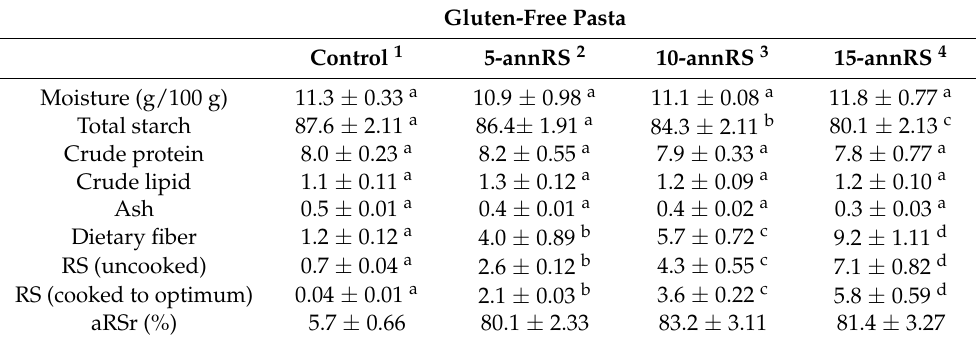
Table 1. Chemical composition (g/100 g dry matter) and apparent resistant starch retention (aRSr, %) of gluten-free macaroni containing resistant starch (RS) from annealed white sorghum starch